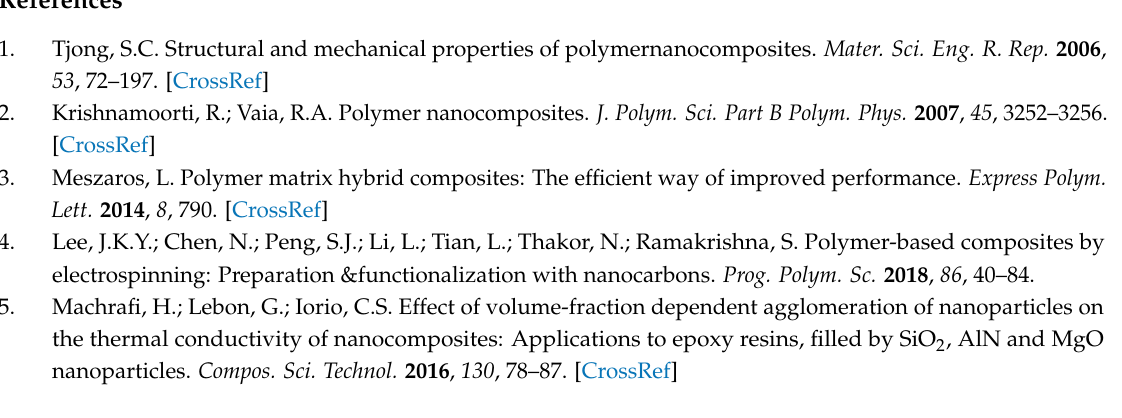
Figure S1 29 Si NMR spectra of POSS1–PECH Figure S2: FTIR spectra of POSS2–PECH, Figure S3: FTIR spectra of POSS3–PECH, Figure S4: FTIR spectra of POSS4–PECH, Figure S5: 1 H NMR spectra of POSS2–PECH, Figure S6: 1 H NMR spectra of POSS3–PECH, Figure S7: 1 H NMR spectra of POSS4–PECH, Figure S8: 13 C NMR spectra of POSS2–PECH, Figure S9: 13 C NMR spectra of POSS3–PECH, Figure S10: 13 C NMR spectra of POSS4–PECH, Figure S11: ATR-IR spectra of PUs with different POSS–PECH, Figure S12: ATR-IR spectra of PUs with different isocyanate index, Figure S13: ATR-IR spectra of PUs with different SiO 2 content S14: ( a ) SEM images of 1.75% POSS modified PU. ( b ) Element mapping images of Si (1.75% POSS modified PU). ( c )SEM images of 4.54% POSS modified PU. ( d )Element mapping images of Si (4.54%POSS modified PU). ( e )SEM images of 7.57% POSS modified PU. ( f )Element mapping images of Si (7.57% POSS modified PU), Figure S15: ( a ) SEM images of 4.75% SiO 2 modified PU. ( b ) Element mapping images of Si (4.75% SiO 2 modified PU). ( c ) SEM images of 7.59% SiO 2 modified PU. ( d ) Element mapping images of Si (7.59% SiO 2 modified PU). ( e ) SEM images of 9.74%SiO 2 modified PU. ( f ) Element mapping images of Si (9.74% SiO 2 modified PU), Figure S16: Loss factor(tan δ ) curves vs temperature for PUs with different T 7 -POSS contents, Figure S17: ( a ) SEM images of 1.77% T 7 -POSS modified PU. ( b ) SEM images of 4.52%T 7 -POSS modified PU. ( c ) SEM images of 7.55% T 7 -POSS modified PU. ( d ) SEM images of 9.73% T 7 -POSS modified PU, Figure S18: TEM images of 1.77% T 7 -POSS modified PU, Figure S19: Loss factor(tan δ ) curves vs temperature for PUs with different T 8 -POSS contents, Figure S20: ( a ) SEM images of 1.76% T 8 -POSS modified PU. ( b ) SEM images of 4.55% T 8 -POSS modified PU. ( c ) SEM images of 7.57% T 8 -POSS modified PU. ( d ) SEM images of 9.75% T 8 -POSS modified PU, Figure S21: TEM images of 1.76% T 8 -POSS modified PU, Table S1: Table S3: Mechanical properties and gel content of PU Composites with different T 7 -POSS content, Table S4: Formulations of PU compositions, Table S5: Summary of DMA data of PUs with different T 8 -POSS contents, Table S6: Mechanical properties and gel content of PU Composites with differentT 7 -POSS